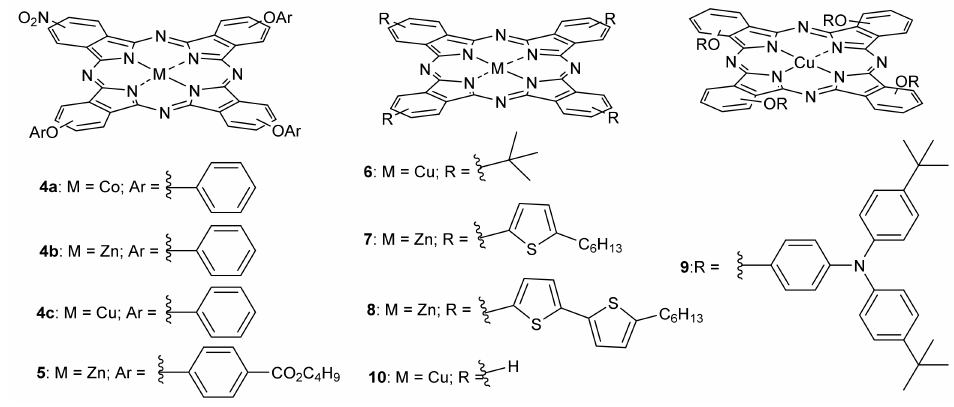
Figure 5. Pcs used in perovskite solar cells.